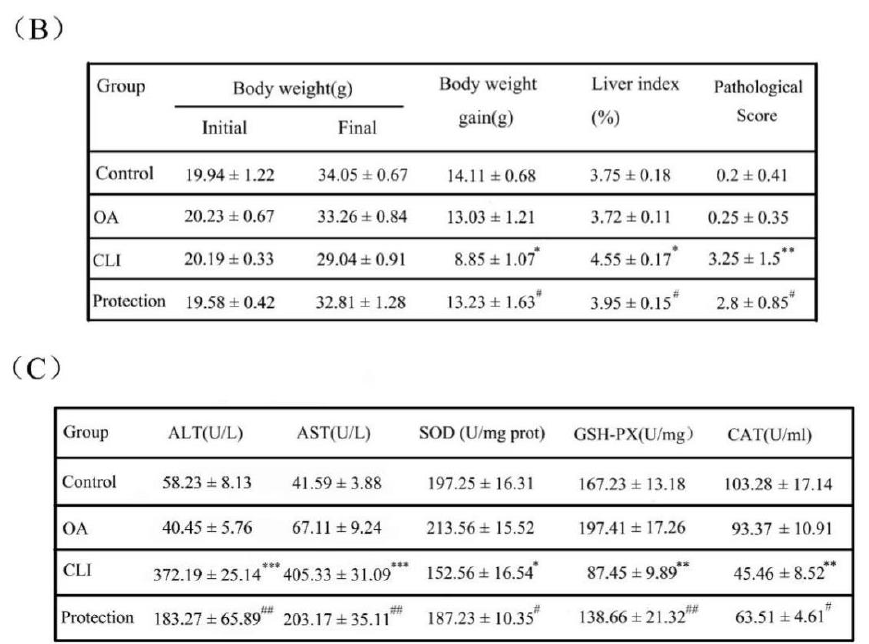
Figure 2. Hepatoprotective effect on carbon tetrachloride (CCl 4 )-induced chronic liver injury in mice. ( A ) Liver tissue of mice and corresponding hematoxylin-eosin (HE) staining. Groups were as described in “Methods: animal”. The tissue was enlarged locally and diffusion miliary dots were observed in the chronic liver injury (CLI) group; the HE staining was 200×; ( B ) Body weight gain, liver index, and pathological score. Groups were as described in “Methods: animal”; ( C ) The activity of alanine transaminase (ALT), aspartate aminotransferase (AST), superoxide dismutase (SOD), glutathione peroxidase (GSH-PX), and catalase (CAT). Groups were as described in “Methods: animal”. Data was the mean ± SD of n = 10 mice/group. * p < 0.05, ** p < 0.01, *** p < 0.001 compared with the control group and # p < 0.05, ## p < 0.01 compared with the CLI